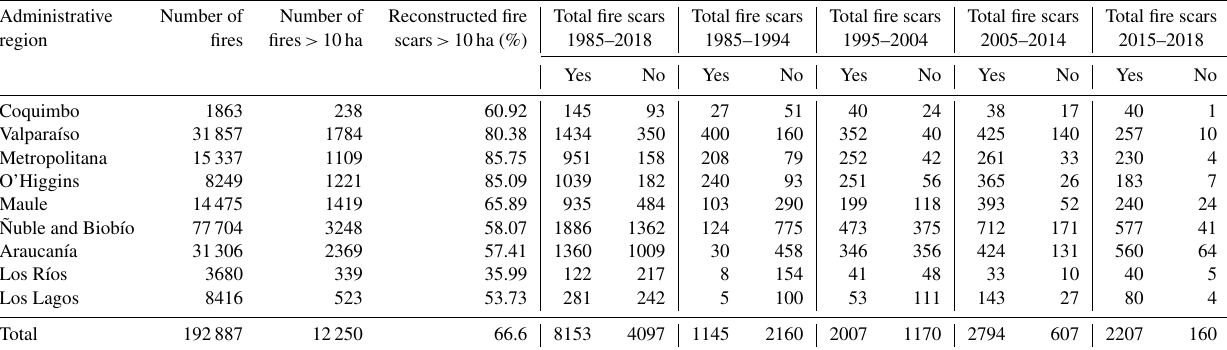
Table 2. Regional and temporal distribution of fires and reconstructed fire scars. The administrative regions are those included in the study. The “Number of fires” column indicates the total number of fires recorded by CONAF for which the burned area was over 0.01ha. “Yes” denotes the number of reconstructed fire scars contained in our database, and “No” denotes the number of fire scars in the database that could not be reconstructed due to the unavailability of satellite